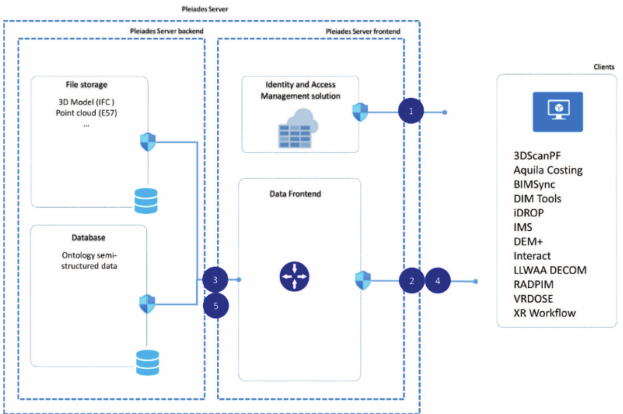
Fig. 6. PLEIADES platform high- level architecture.